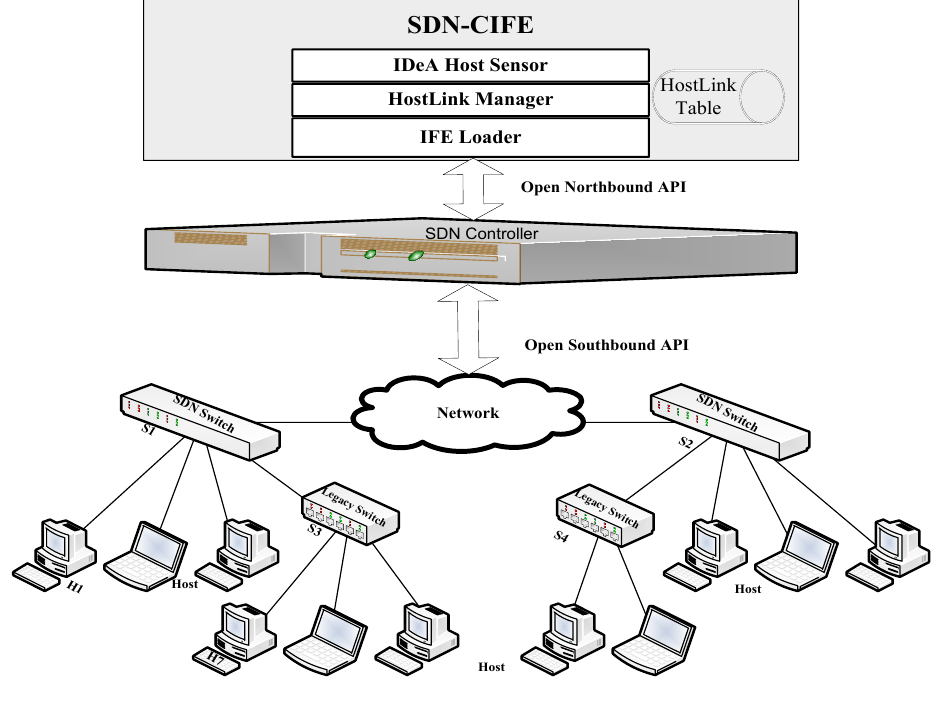
Figure 1. Architecture of SDN-CIFE.